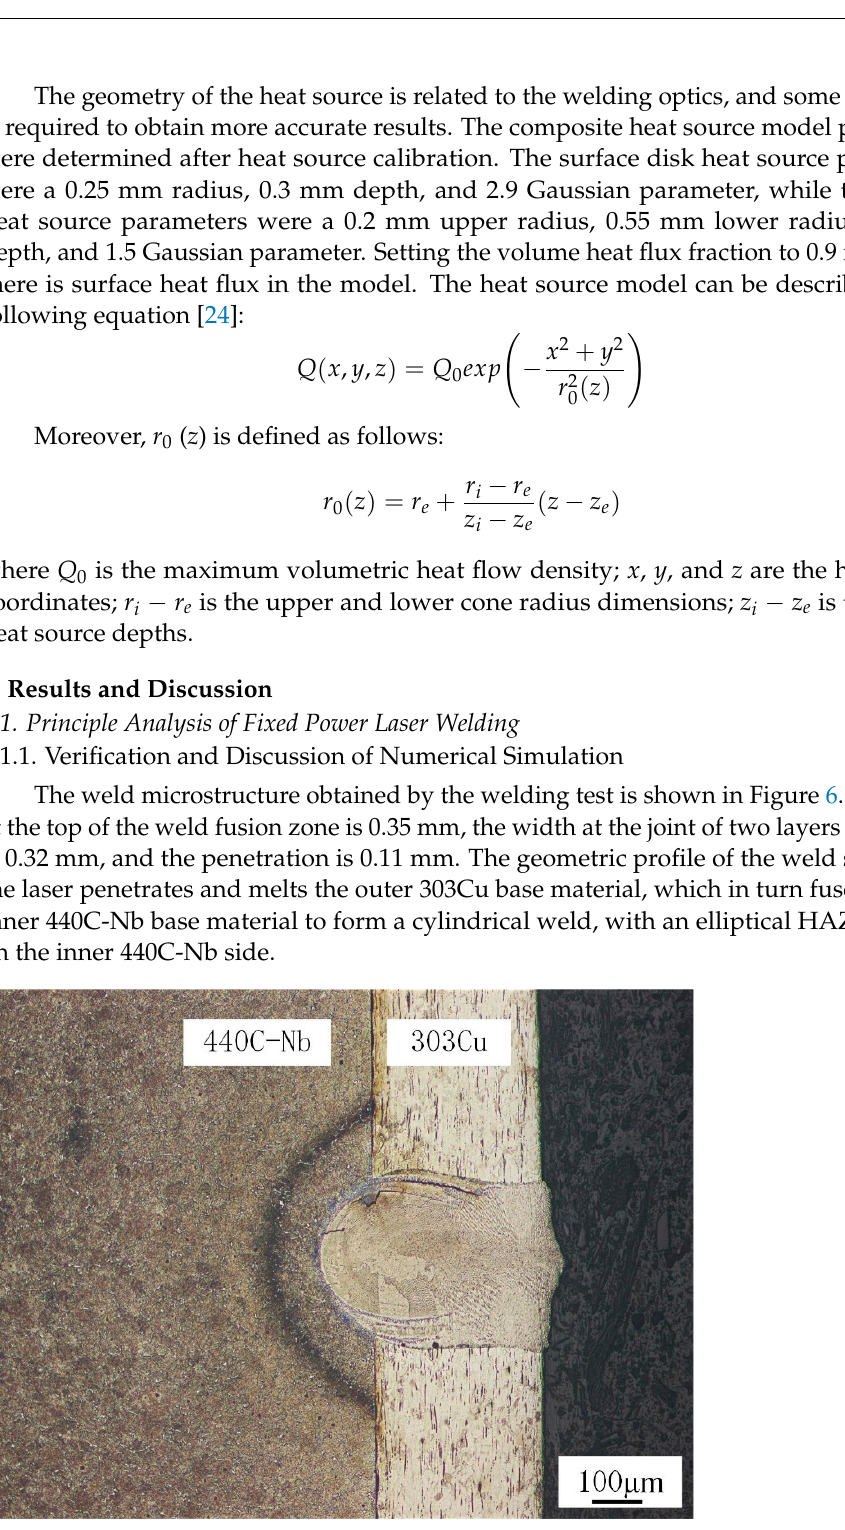
Figure 6. Weld microstructure.